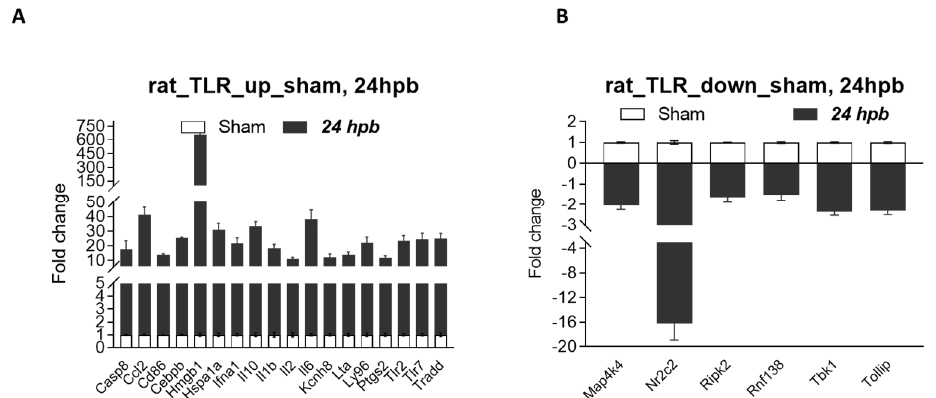
Figure 6. Validation of burn-induced regulated genes using qPCR. Triplicate total RNA samples from rat hearts (either sham healthy or 60% TBSA burn for 24 h) were transcribed to cDNA; then, real-time qPCR was run with our own designed primers (Table 1); ( A ) burn-injury-induced up-regulated TLR-related DEGs, and ( B ) burn-injury-induced down-regulated TLR-related DEGs.